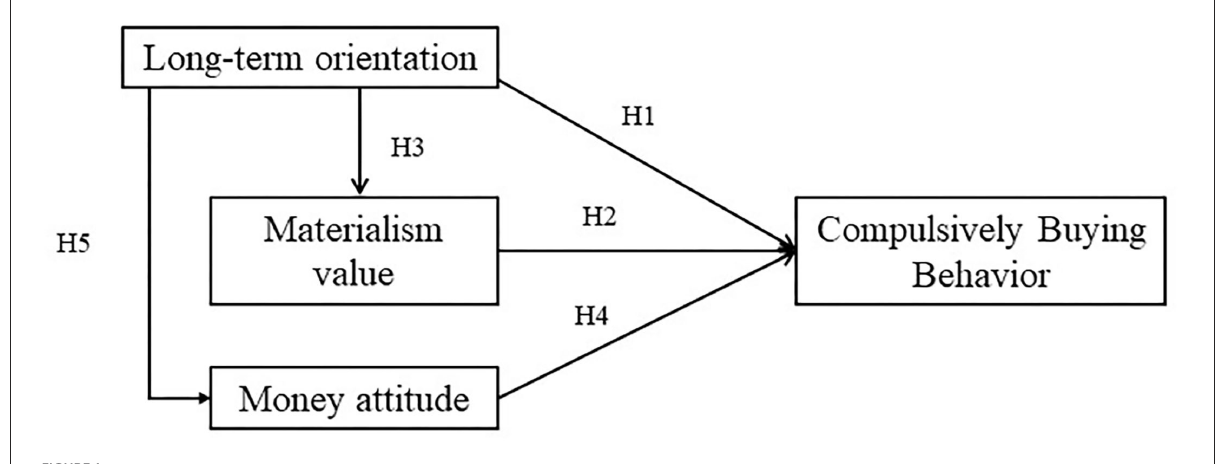
FIGURE1 Conceptual